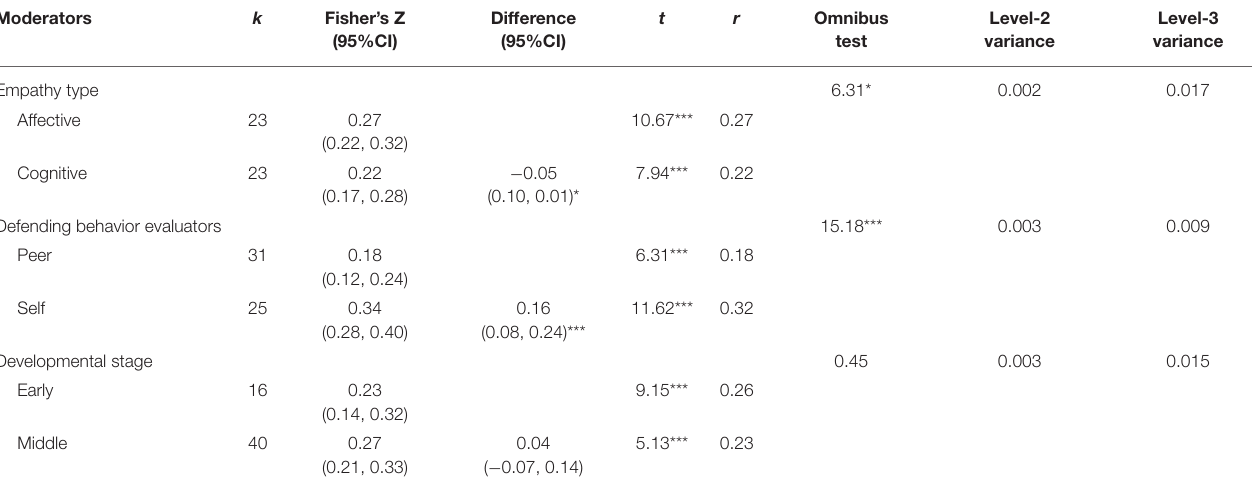
TABLE 2 | Results for the moderators of empathy and